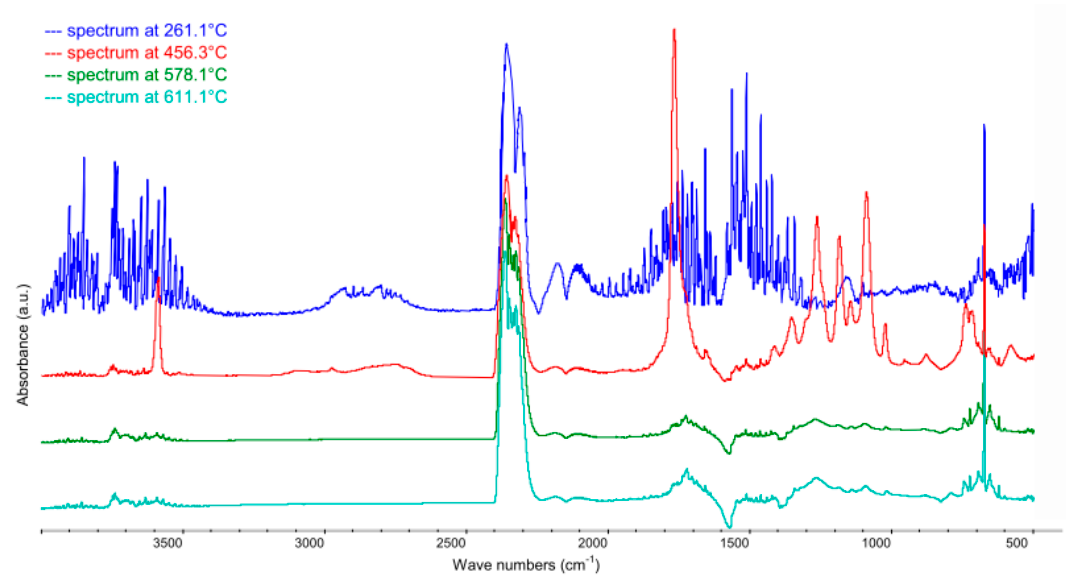
Figure 9. FTIR spectra recorded for PET modified with C15A (0.5%) in the range of 500–4000 cm − 1 at temperatures characteristic of its oxidative degradation process: 261.1 °C (13.7 min), 456.3 °C (23.3 min), 578.1 °C (29.3 min), 611.1 °C (31.0 min), respectively, determined on the basis of DTG curves.